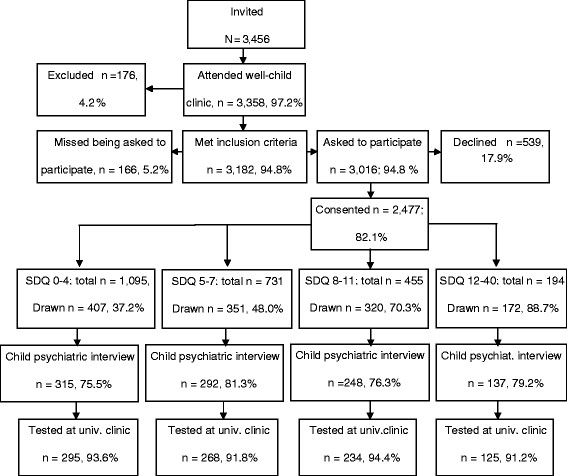
Sample recruitment.